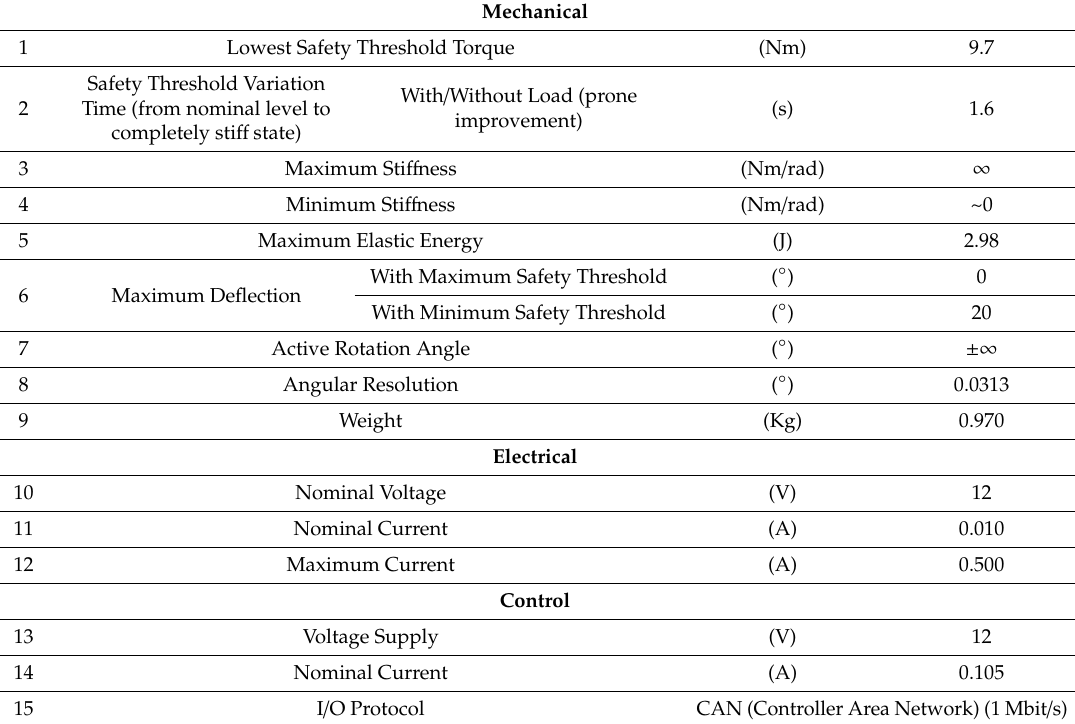
Table A1. V2SOM mechanical and electrical